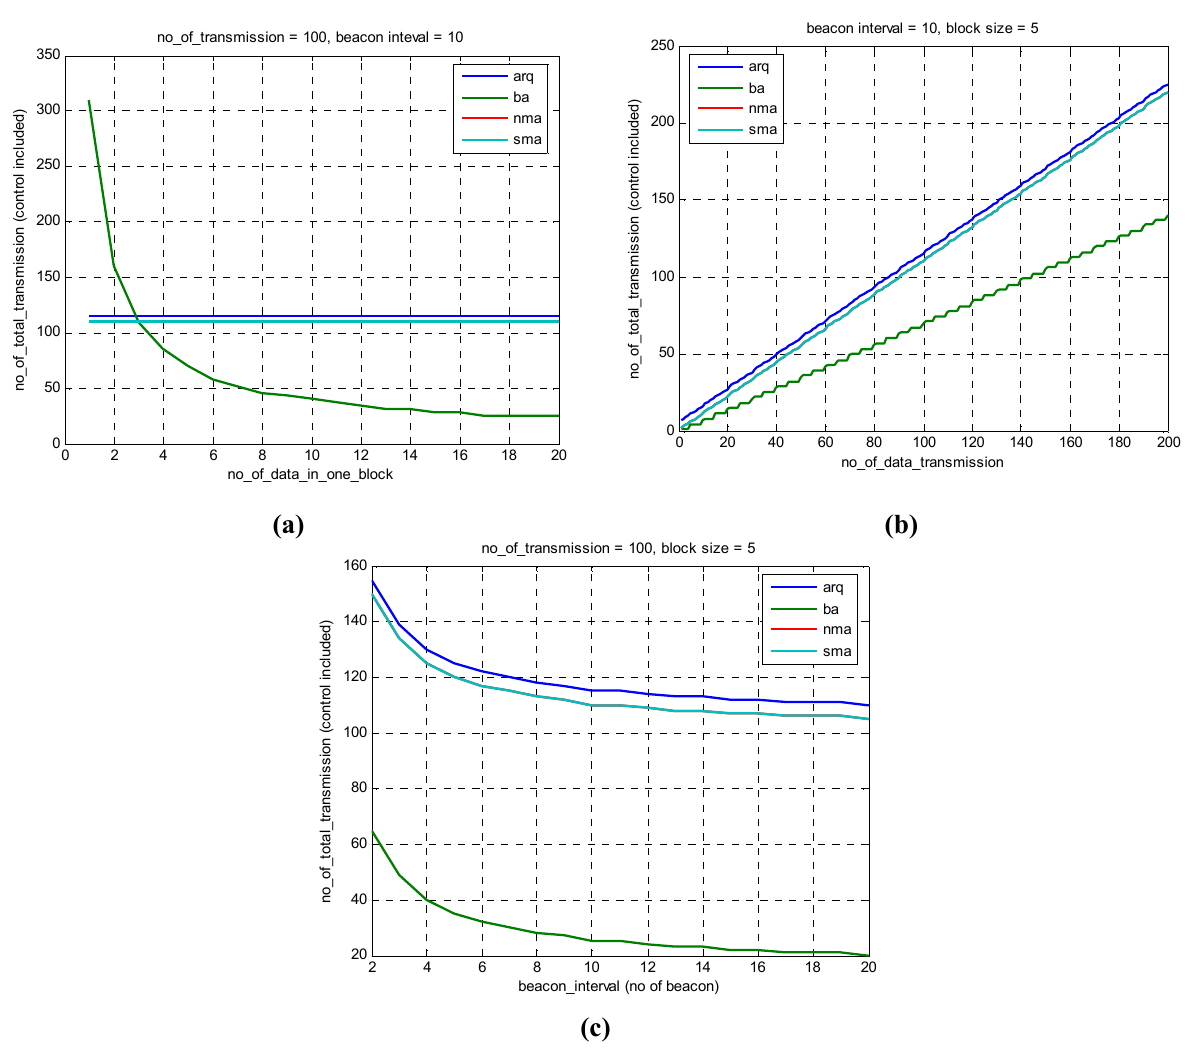
Figure 12. Number of total transmission: (a) variable block (b) variable data tx (c) variable beacon interval.